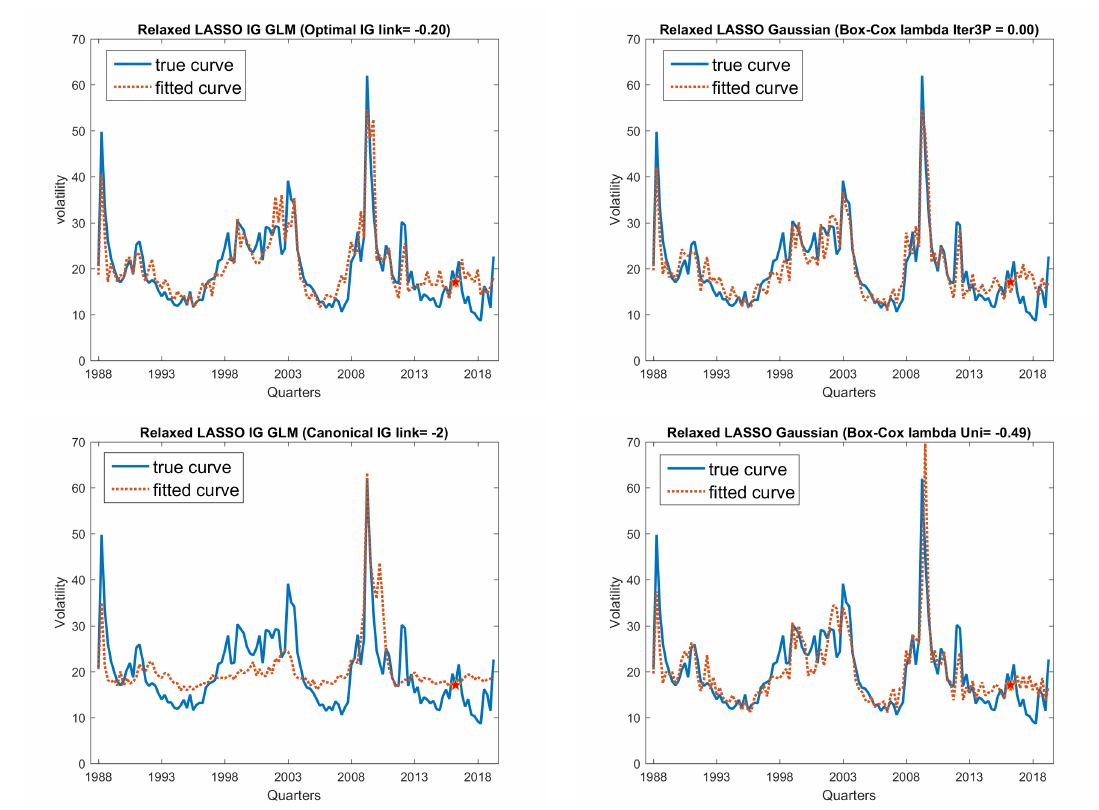
Figure 8. Fitted curve in comparison with true curve: VXO on macro + FinR data.